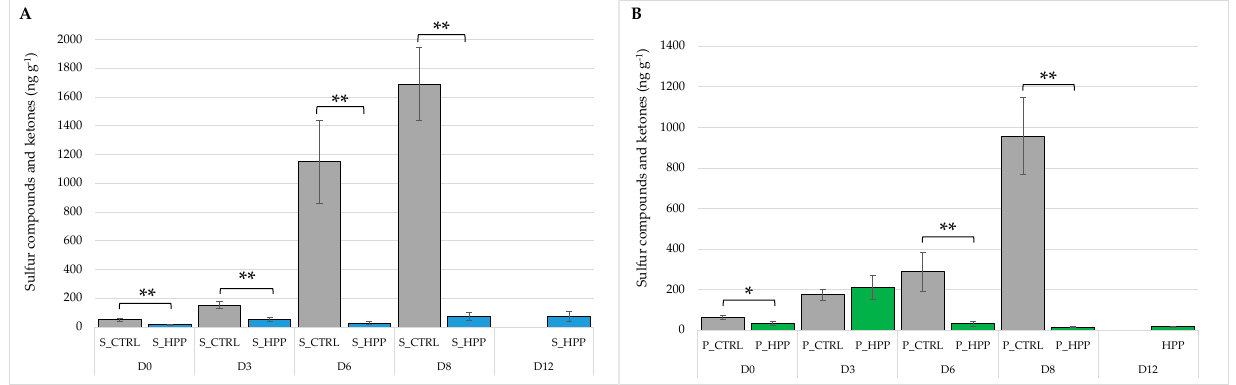
Figure 1. Trend of sulfur compounds and ketones on salmon (S_CTRL and S_HPP; ( A )) and plaice (P_CTRL and P_HPP; ( B )) fillets during shelf-life. The bar graphs show mean ( n = 3) ± standard deviation. Significant effect of groups is highlighted by asterisks: * p ≤ 0.05; ** p < 0.01.